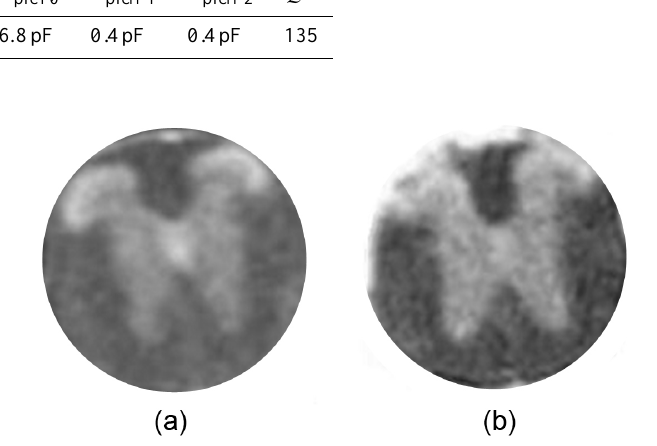
Figure 8. Ex vivo MR images (multi-echo multi-slice sequence: TR = 1155ms; TE = 14ms; NE = 1; FOV = 10mm × 10mm; 60 slices; thickness = 0.6mm; resolution = 256 × 256) of spinal cords from adult mice. Hypersignal (butterfly shape) represents the grey matter whereas the surrounding hyposignal corresponds to the white matter: (a) image obtained with RAPID Biomedical 43mm volumic quadrature coil in 14h 0min; (b) image obtained with the ribbon solenoid coil of Fig. 7 in 1h